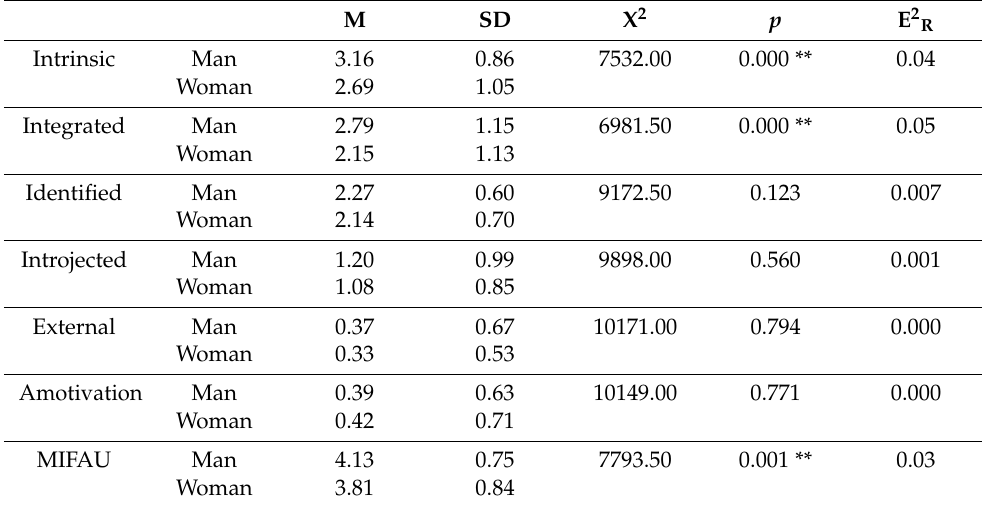
Table 3. Regulation of motivation and intention to engage in PA according to sex. M SD X 2 p E 2 R Intrinsic Man 3.16 0.86 7532.00 0.000 ** 0.04 Woman 2.69